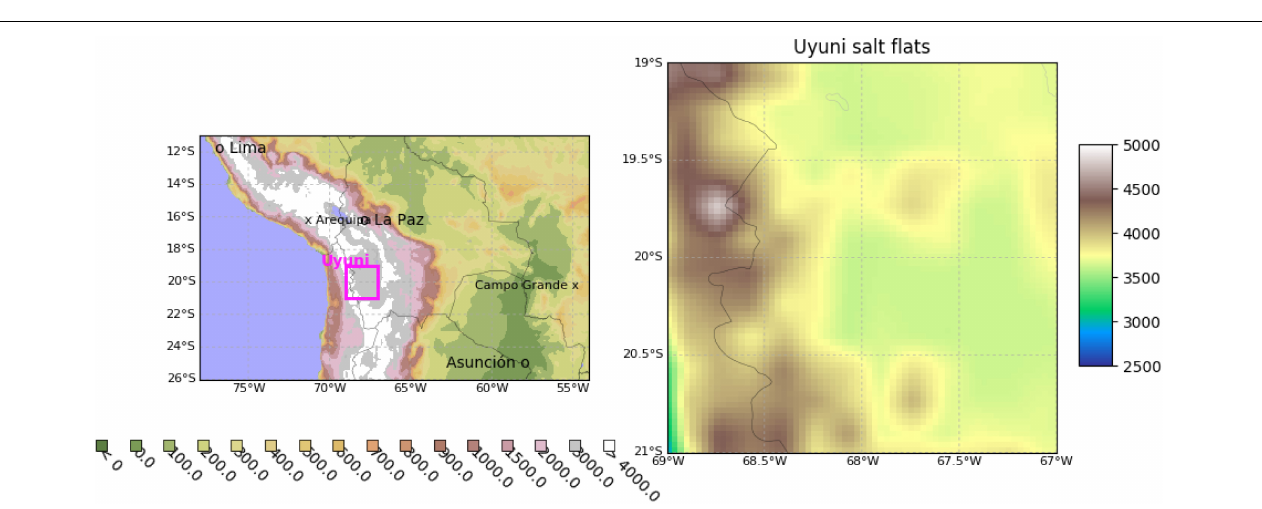
FIGURE 8 | The Uyuni Salt Flats geographical location in Potosi, Bolivia (left). 1-km resolution map of topography (meters) in a 2 ◦ × 2 ◦ box, shows Uyuni region as represented in CMIP5 models